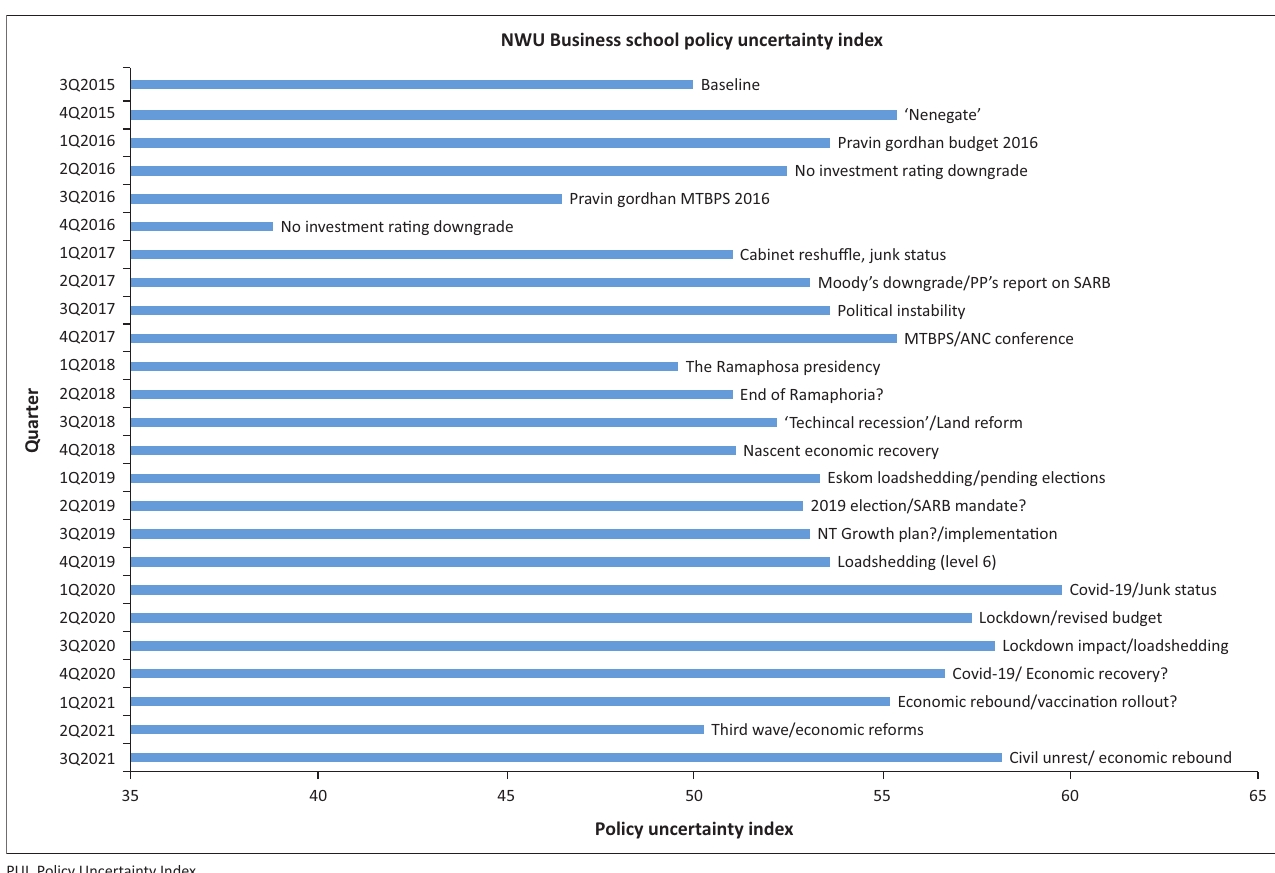
FIGURE 1: The Policy Uncertainty Index and major